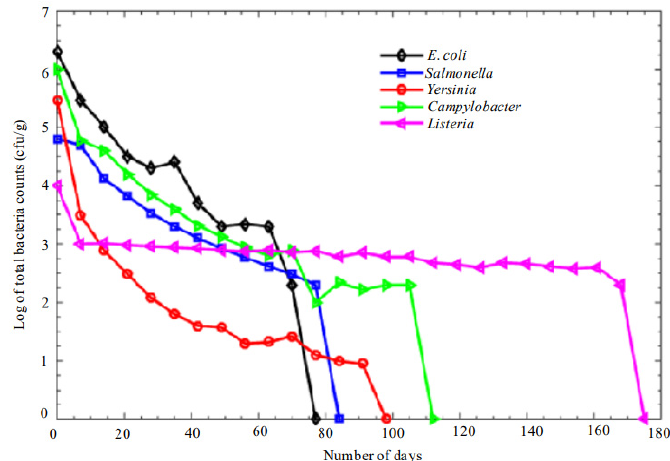
Figure 2. Reduction in bacterial counts of the different species over different retention times.